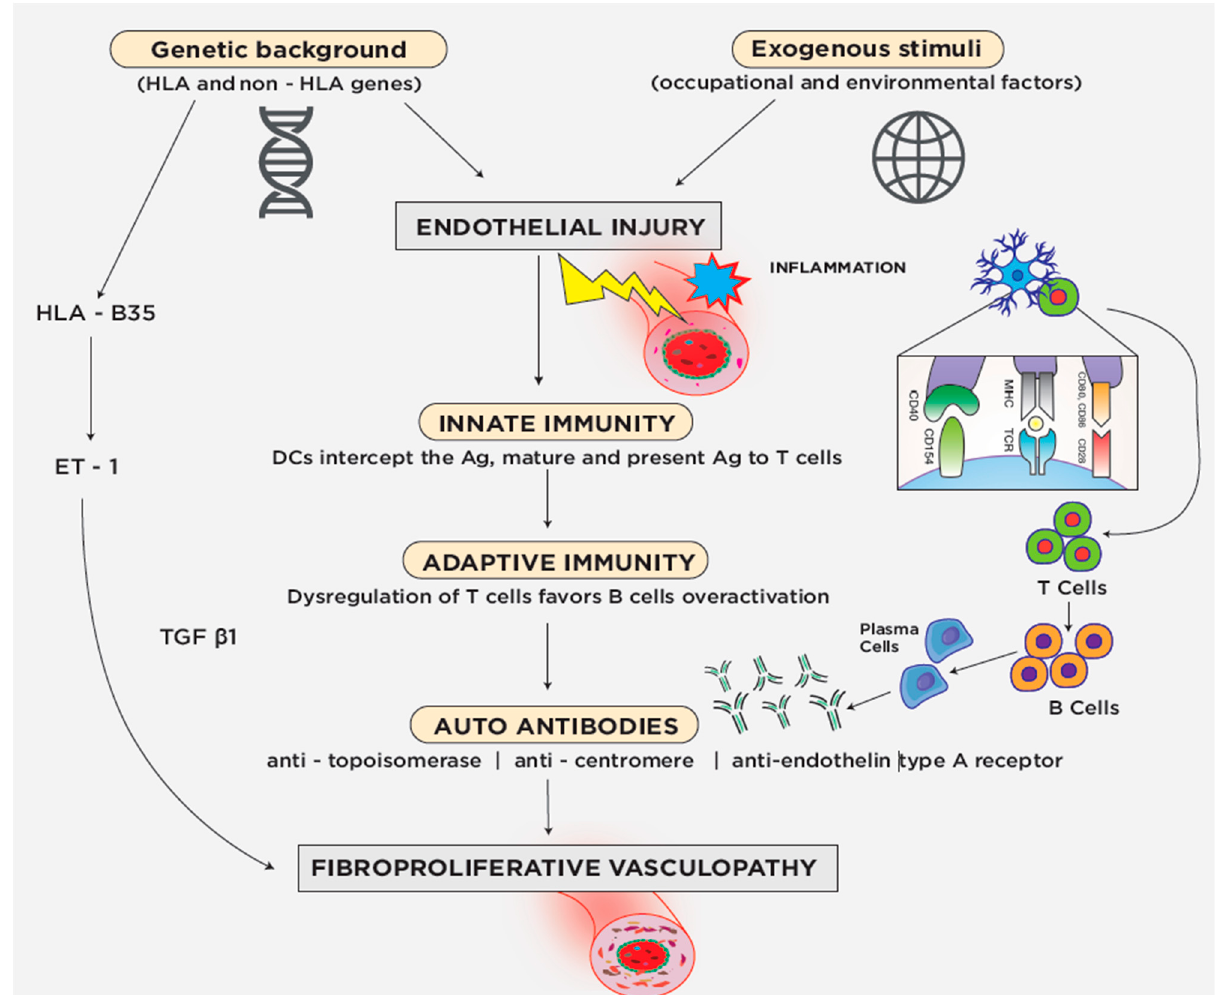
Figure 1. In a predisposed genetic background, an exogenous trigger that targets blood vessels may determine the engagement of inflammatory molecules and cells of the innate immune system. In the inflammatory environment, dendritic cells intercept the antigen, become mature, migrate to lymph nodes, and present the antigen to T cells, activating adaptive immunity through the costimulatory CD40L–CD40 axis. Once activated, T cells release interleukin 2, proliferate and differentiate into effector T cells. However, impaired function of regulator T cells and B cells hyperactivity lead to the production of a plethora of autoantibodies, such as anti-topoisomerase I, anti-centromere and anti-endothelin type A receptor antibodies.